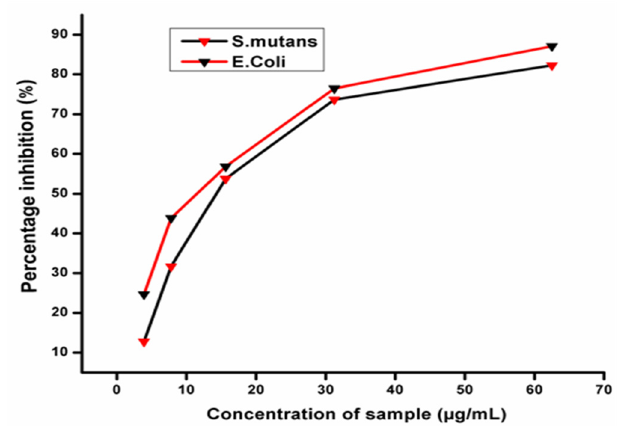
Figure 2. Antibacterial activity of